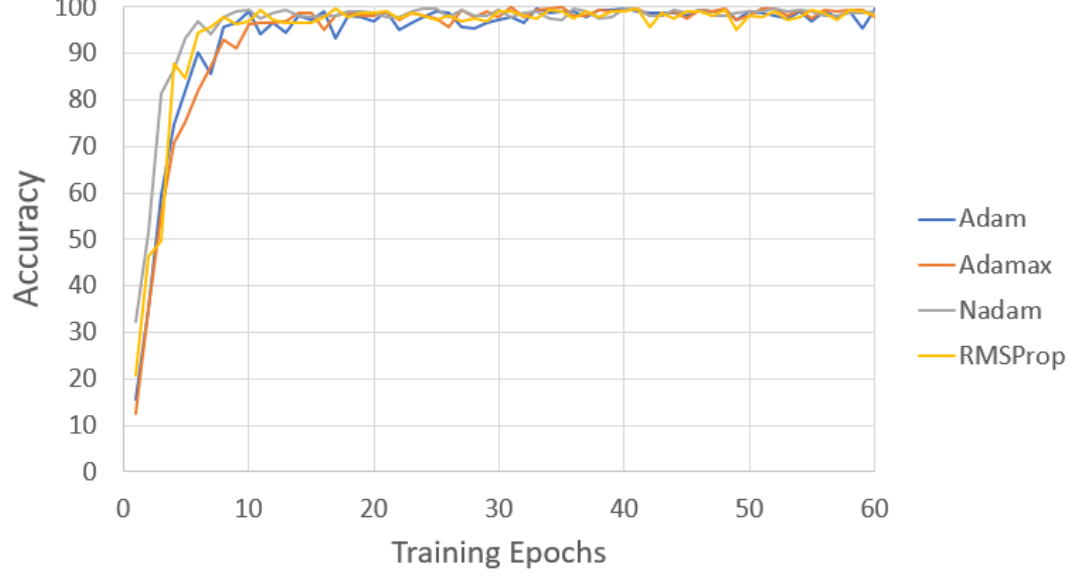
Figure 8. Optimizer training curve comparison using TB5 free-space data set with ResNeXt 50 architecture. Accuracies are recorded after each training epoch for a total of 60